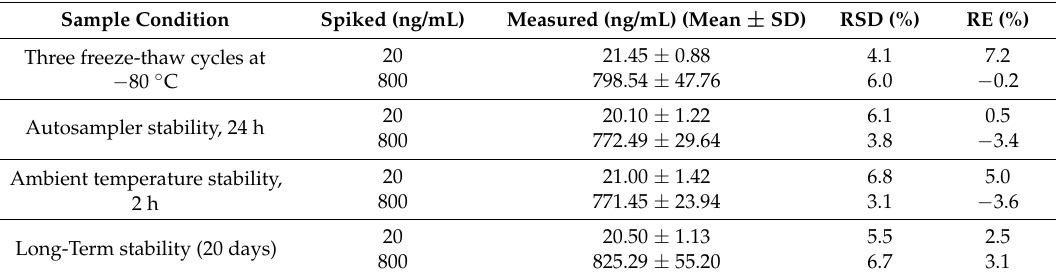
Table 3. Stability of sodium danshensu in beagle dog plasma ( n = 3).